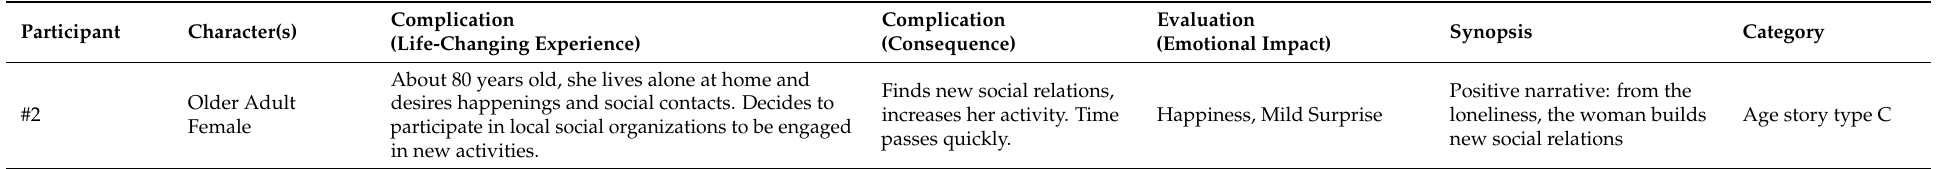
Table 3. An example of the creation of the synopsis for one of the Age Workshop stories and its